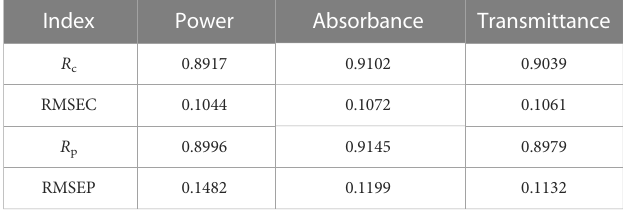
TABLE 4 Results of single-dimension models.